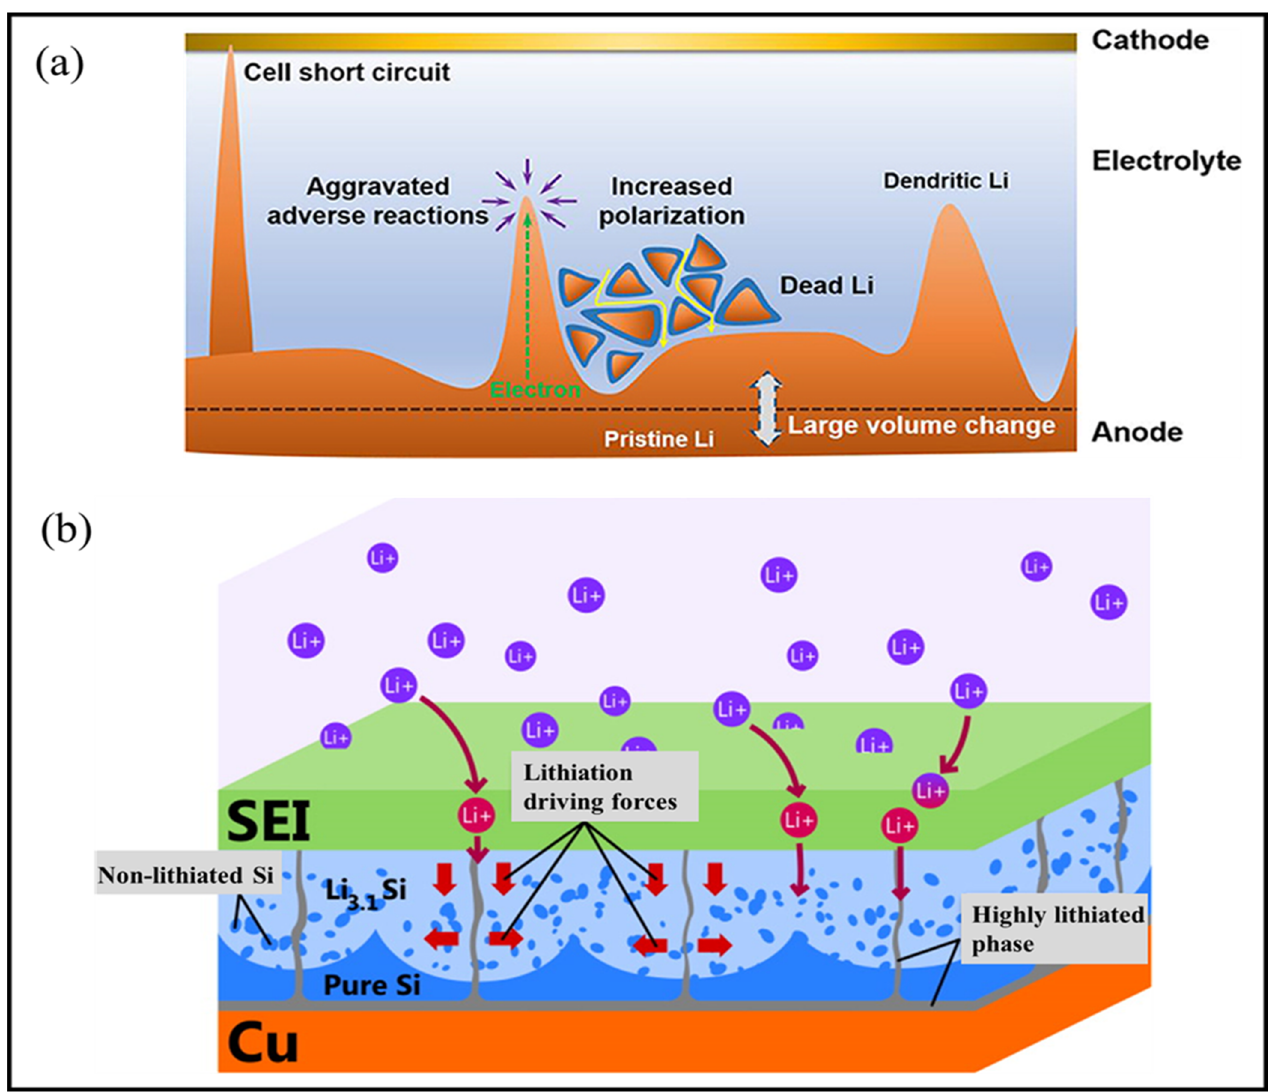
Figure 4. Scheme of the dilemma of Li-metal anodes ( a ) [90]; and Si thin film anodes ( b ) in recharge- able ba tt eries [95].